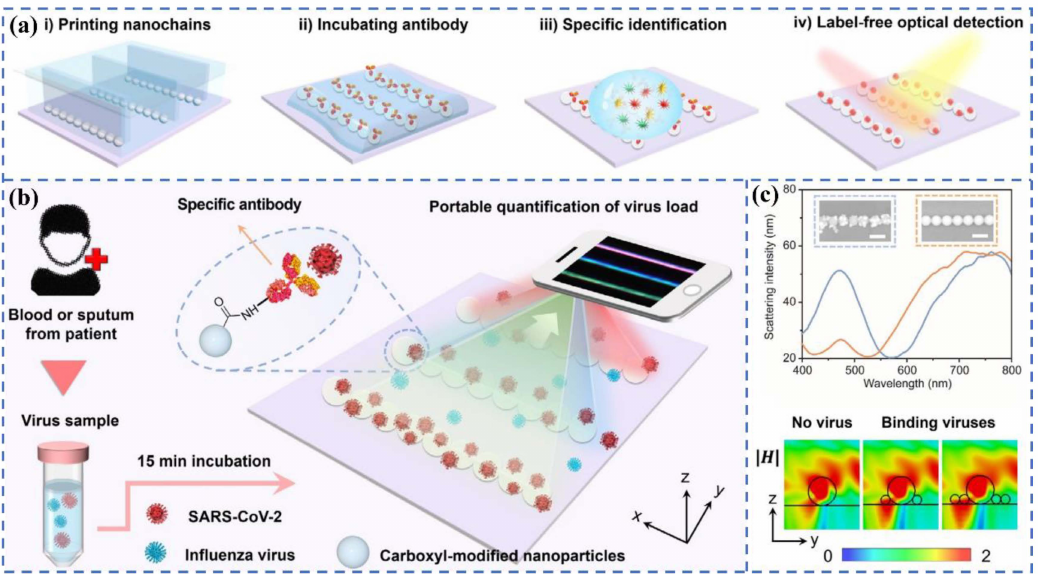
Figure 6. ( a ) Flow chart of the direct colorimetric detection of SARS-CoV-2 in serum or sputum using printed nanochains. ( b ) Quantitative monitoring of virus particles: the color change of nanochains can be observed using a smart phone. ( c ) Scattering spectra and magnetic field distribution before and after viral particle binding. Reprinted with permission from ref. [68]. Copyright 2021,